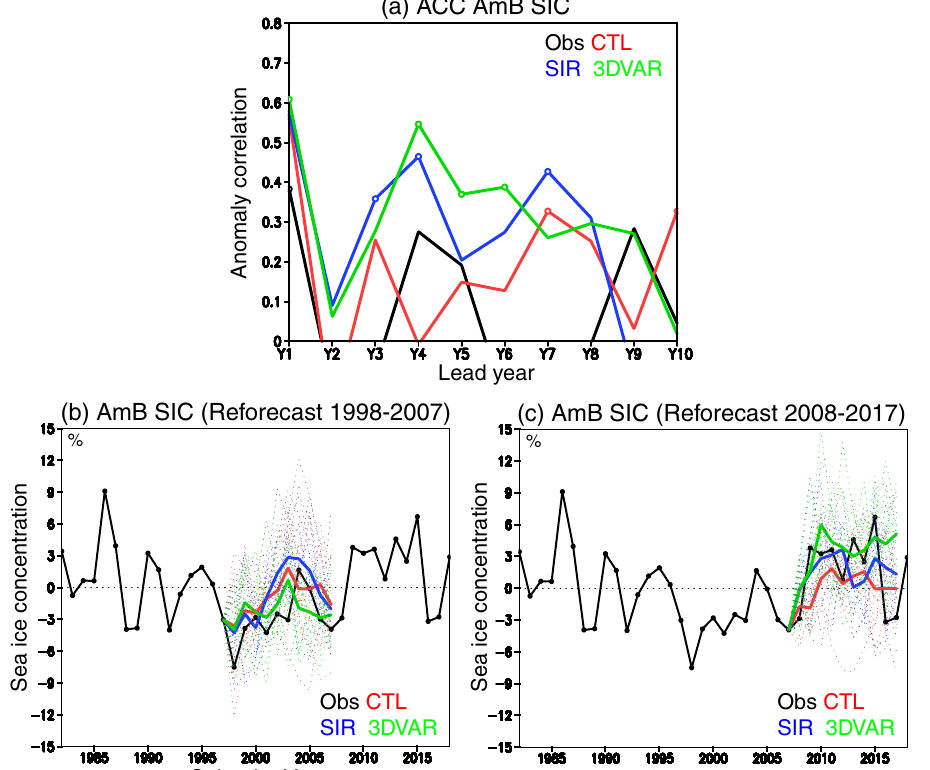
Fig. 2 Prediction skills of decadal sea ice concentration (SIC) variability in the Amundsen – Bellingshausen (AmB) Sea. a Time evolution of the ACCs of the yearly mean SIC anomalies averaged in the Amundsen – Bellingshausen Sea (AmB; 120° − 60°W, 70° − 60°S) between the observation and the reforecast experiments for each lead year. A black line indicates autocorrelation with the observed SIC anomalies, while red, blue, and green lines show the ACCs from the CTL, SIR, and 3DVAR experiments, respectively. Open circles indicate positive ACCs which are statistically signi fi cant at 90% con fi dence level using Student ’ s t test. b Time series of the yearly mean SIC anomalies averaged in the AmB region. We calculated the anomalies with respect to the period of 1982 – 2018. A black line shows the observed SIC anomalies, while colored lines show the SIC anomalies predicted from March 1st 1998 in the CTL (red), SIR (blue), an 3DVAR (green) experiments. Thick colored lines indicate the average of 12 ensemble members with different initial conditions, and dotted colored lines correspond to each ensemble member. c Same as in b , but for the SIC anomalies (in %) predicted from March 1st